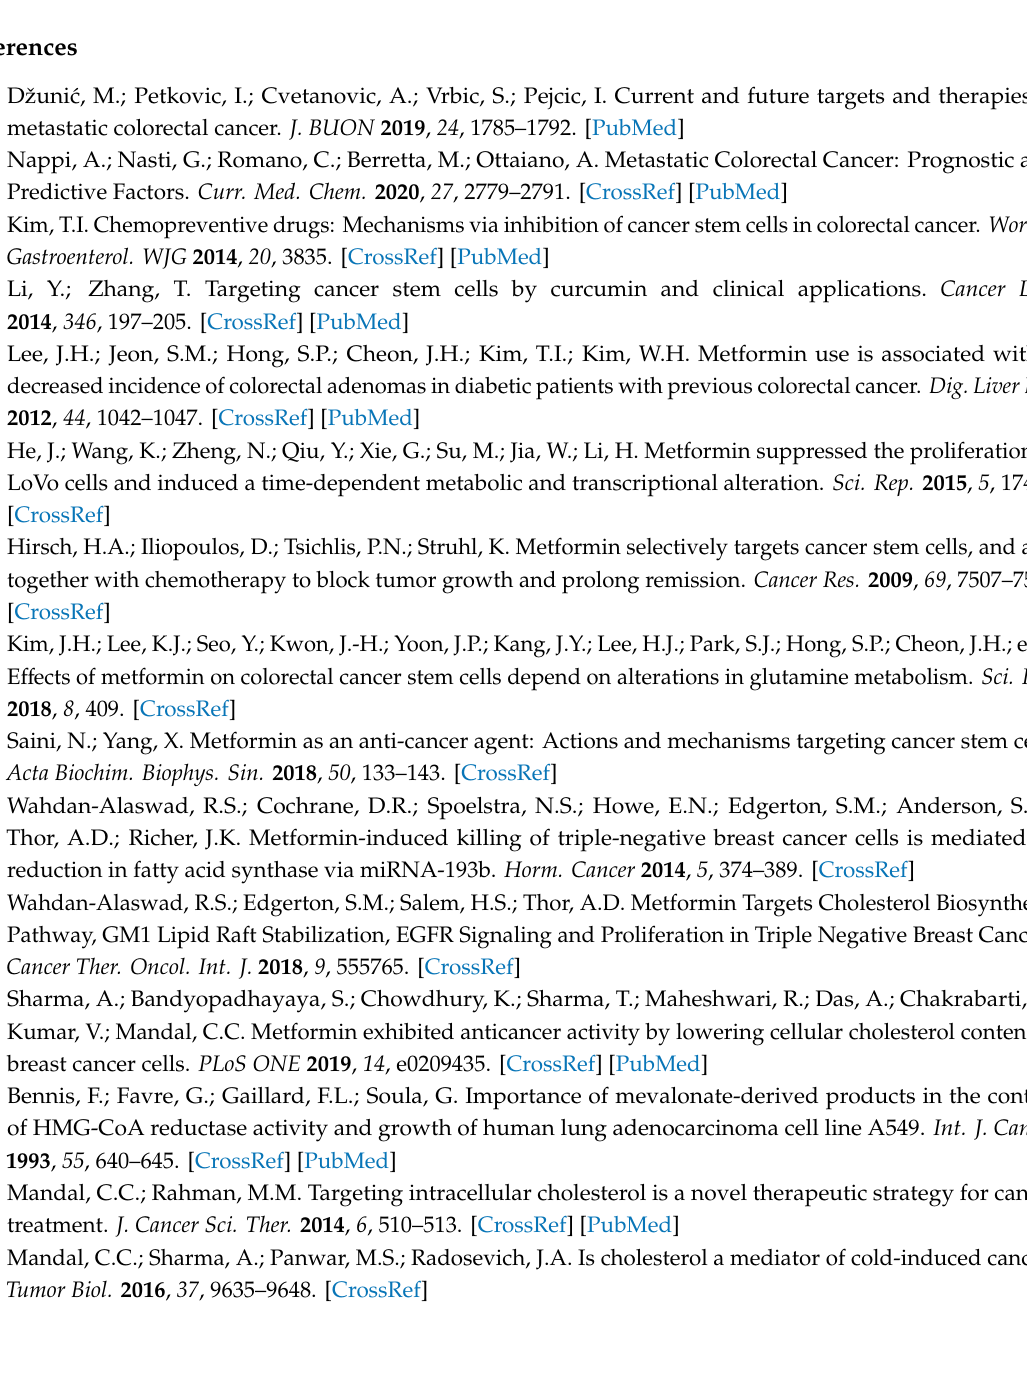
Figure S1: Western blot analysis to identify change of shifted prenylated protein of RAS and Ral A, Figure S2: IHC to evaluate expression of Ki67 in xenograft tumor, Figure S3: Western blot and qPCR analysis of major signals and key enzymes in metformin-resistant SW620 cells, Table S1: Sequences of the primers used in qPCR, Table S2: List of antibodies, Table S3: List of drugs used in